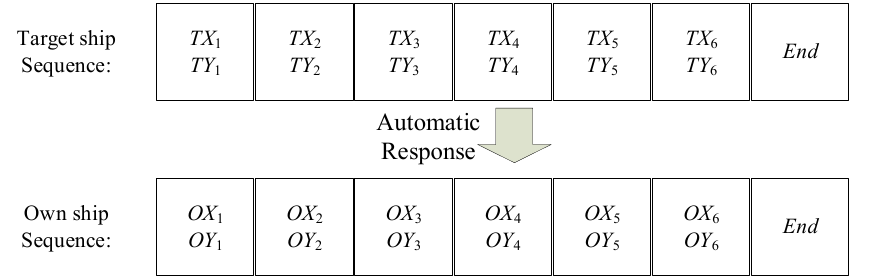
Figure 12. Conversion of the Seq2Seq model.